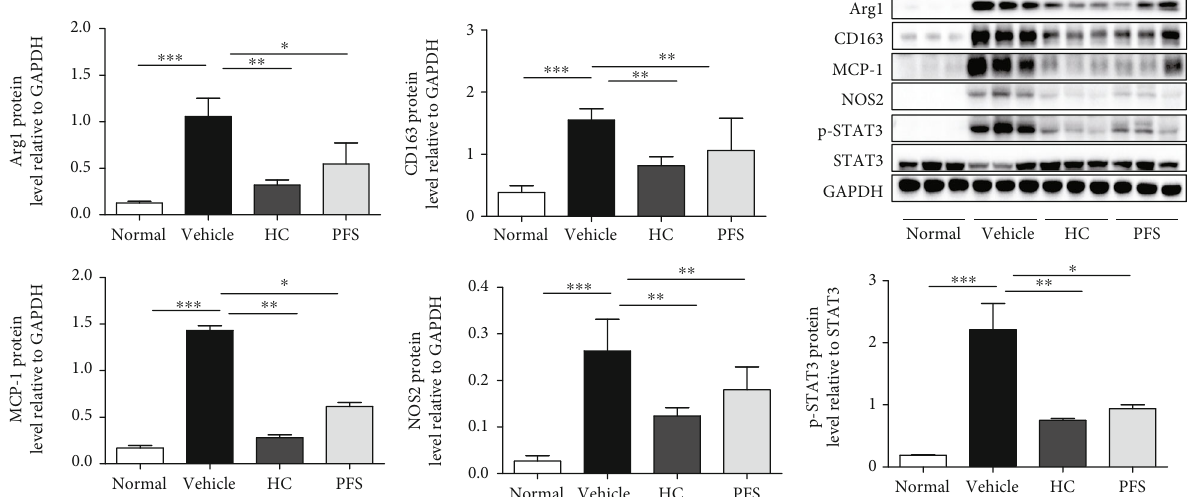
Figure 5: PFS suppressed the protein expression of macrophage factors in oxazolone-induced BALB/c mice (ten-time challenge). The expression of macrophage marker and STAT3 in AD skin lesion was evaluated by a western blot analysis. The histogram bars represent three independent experiments. Data are expressed as mean ± SD , ∗ p < 0 : 05 , ∗∗ p < 0 : 01 , and ∗∗∗ p < 0 : 001 versus the vehicle group.